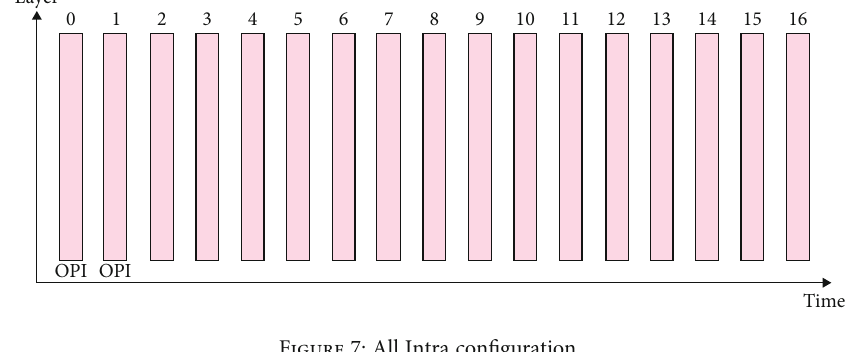
Figure 7: All Intra con fi guration.